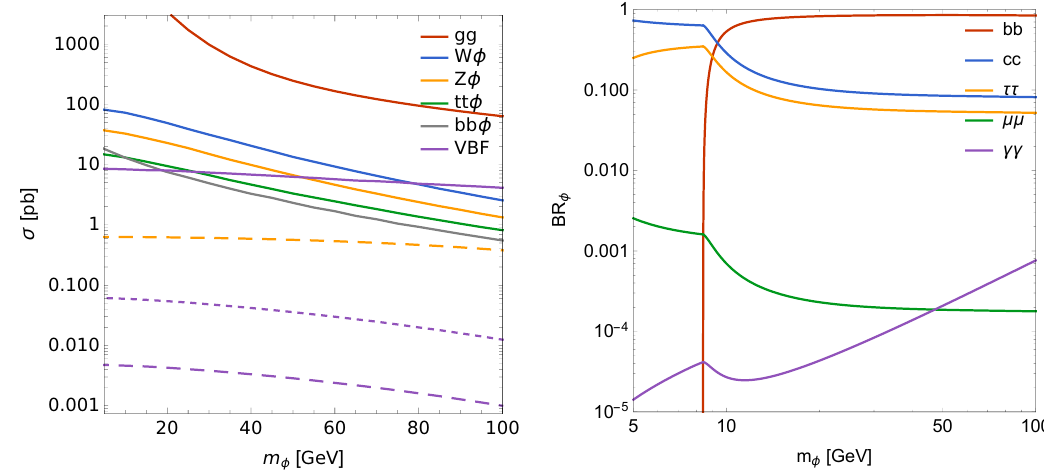
Figure 3 . Production and decay of (cid:30) via CP -even couplings for sin 2 (cid:18) = 1. Left: hadronic cross p sections in solid lines, (cid:27) ( pp ! X ) at s = 13 TeV for X = (cid:30) (via gluon fusion), W(cid:30) , Z(cid:30) , t (cid:22) t(cid:30) , b (cid:22) b(cid:30) p and (cid:30)jj (via VBF). Leptonic cross sections in dashed lines, (cid:27) ( e + e (cid:0) ! Y ) at s = 240 GeV for Y = (cid:30)Z; (cid:30)(cid:23) e (cid:22) (cid:23) e (via W -fusion, dotted) and (cid:30)e + e (cid:0) (via Z -fusion, dashed). The (cid:27) ( pp ! (cid:30) ) via gluon fusion is calculated using ggHiggs v3.5 [123{126] at N 3 LO including N 3 LL resummation without a p T -cut. The remaining hadronic cross sections are obtained from MadGraph5 aMC [127] at NLO with p T ( (cid:30) ) > 20 GeV; the leptonic VBF cross sections at LO with p T ( (cid:30); e + ; e (cid:0) ) > 10 GeV. The leptonic Z(cid:30) cross section was analytically calculated with eq. (4.18), also with p T ( (cid:30) ) > 10 GeV. Right: branching ratios BR( (cid:30) ! b (cid:22) b; c (cid:22) c; (cid:28) + (cid:28) (cid:0) ; (cid:22) + (cid:22) (cid:0) ; (cid:13)(cid:13)